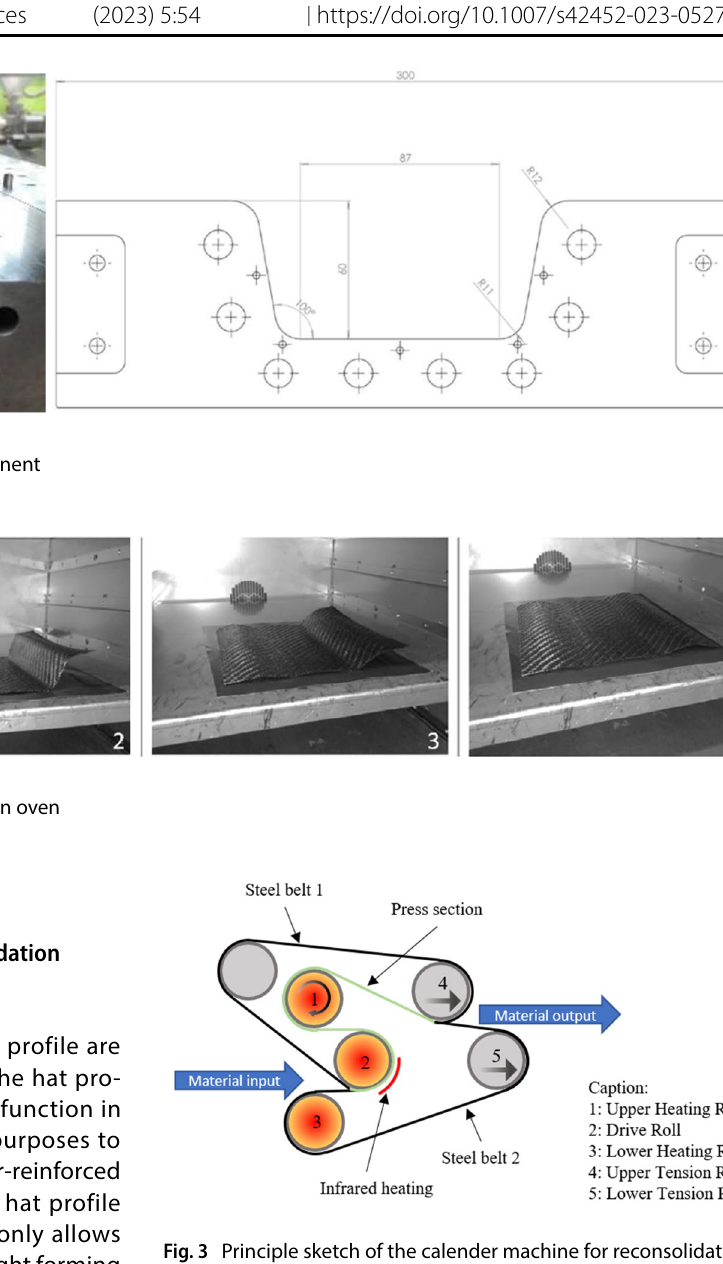
Fig. 3 Principle sketch of the calender machine for